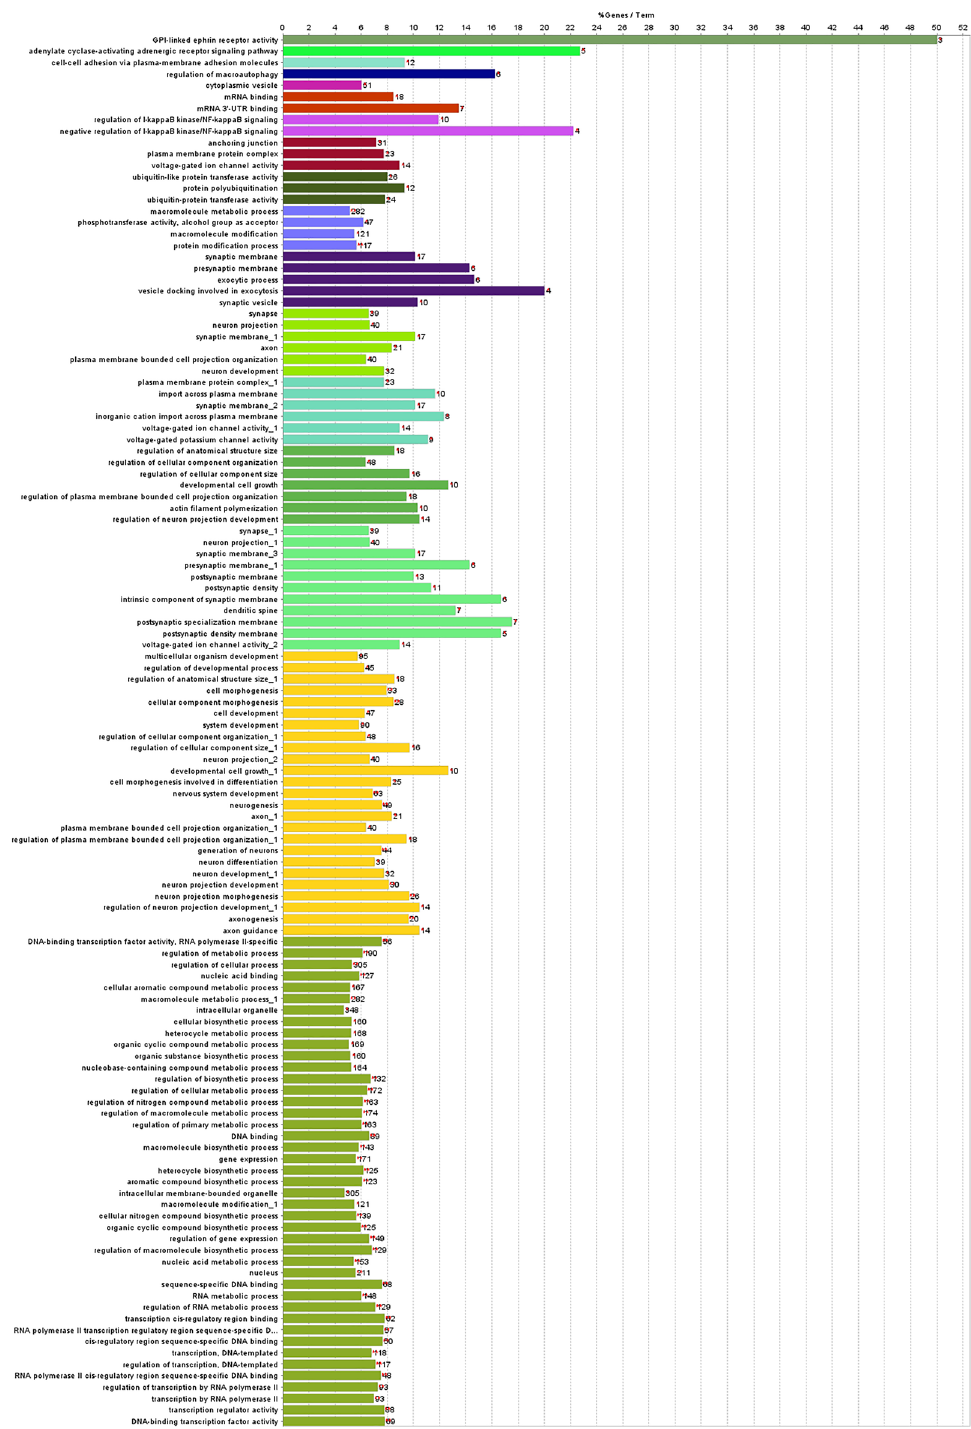
Figure 4. Results for enrichment analysis for target genes of gga-miR-1612: percentage of genes per significant